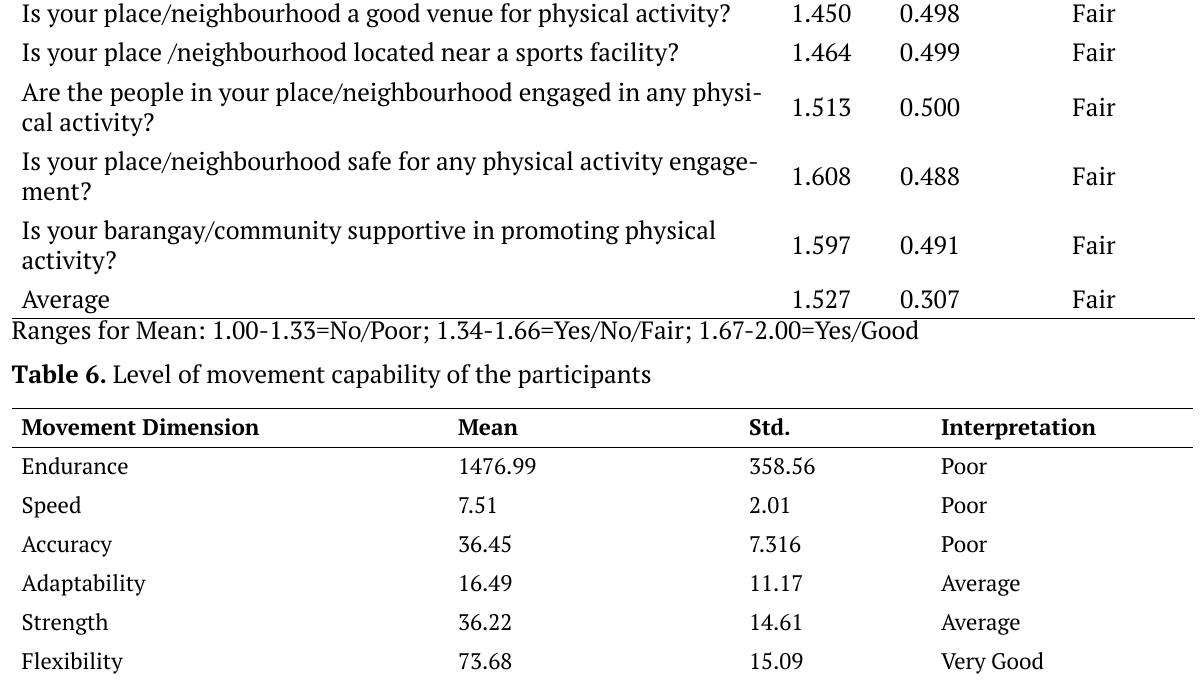
Table 5. Students’ environment for physical activity Indicators